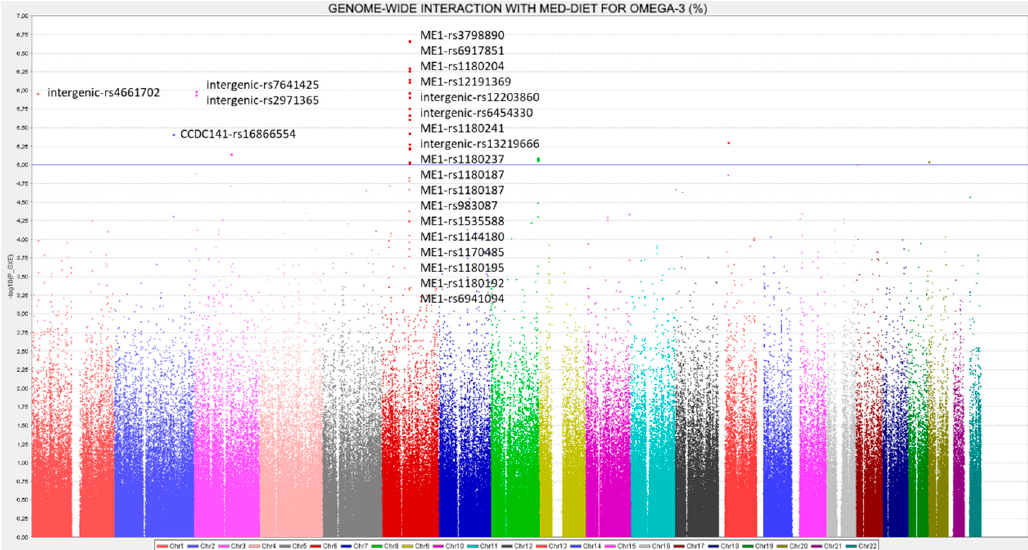
Figure 5. Manhattan plot for the genome-wide interaction with adherence to Mediterranean diet in determining serum omega-3 fatty acid (%) in the whole population. p -values for the gene*diet interaction terms were obtained in the additive model for the SNPs and diet expressed as dichotomous (low and high adherence to the Mediterranean diet) and expressed as − log 10 ( p -value). The blue line represents the threshold for suggestive GWAS signi fi cance ( − log 10 (1 × 10 − 5 )).